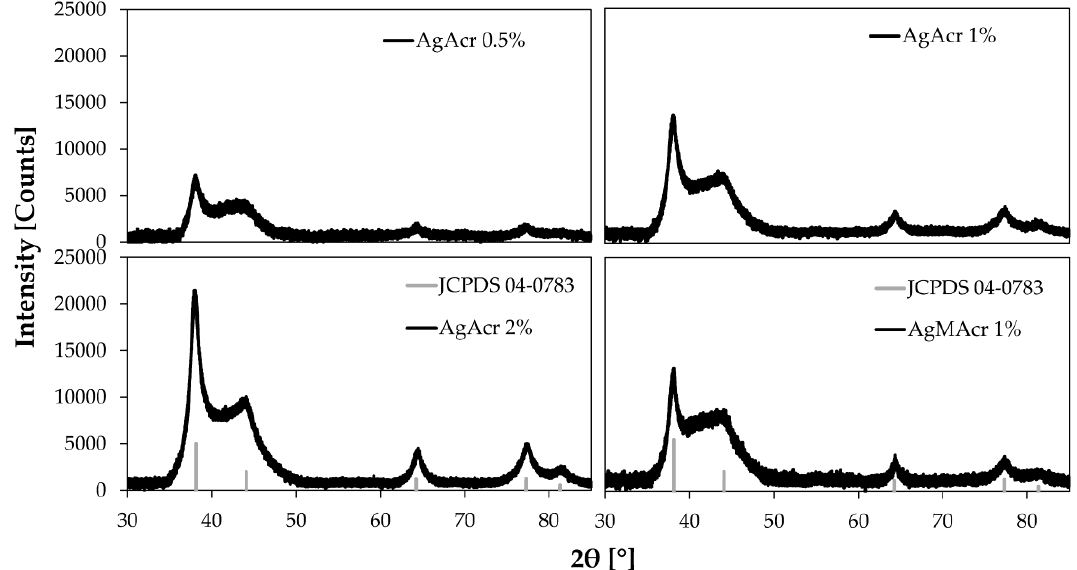
Figure 2. X-ray diffraction (XRD) diffraction pattern of 3D printed materials containing different amount of AgNPs from AgAcr and AgMAcr as precursors.